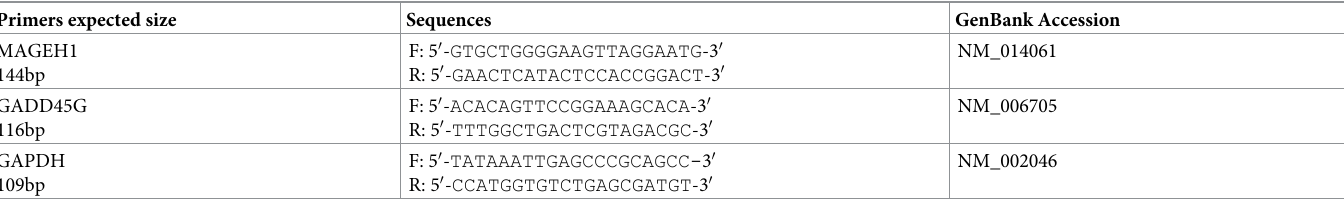
Table 1. Primers used in qPCR.